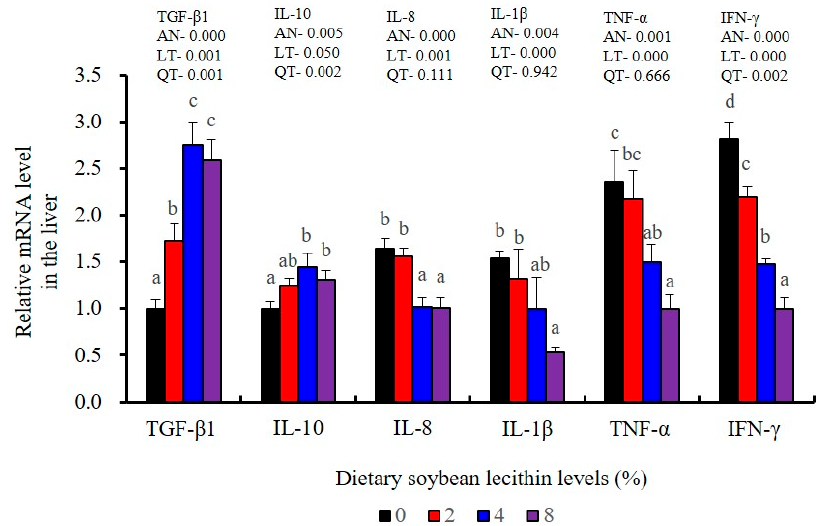
Figure 4. E ff ects of dietary soybean lecithin on relative gene expression levels of mitogen-activated protein kinase (MAPK) signal pathway in the liver of juvenile largemouth bass. Bars with di ff erent le tt ers indicate signi fi cant di ff erences ( p < 0.05), while that with the same le tt er or no le tt er super- scripts indicate no signi fi cant di ff erences ( p > 0.05), AN: ANOVA, LT: linear trend, QT: quadratic trend.